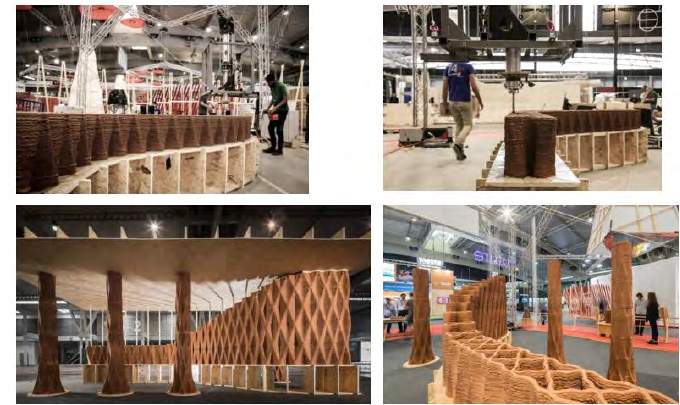
Figure 15. Robotos driven by cables & drones have helped in 3D printing using clay in printing large scale